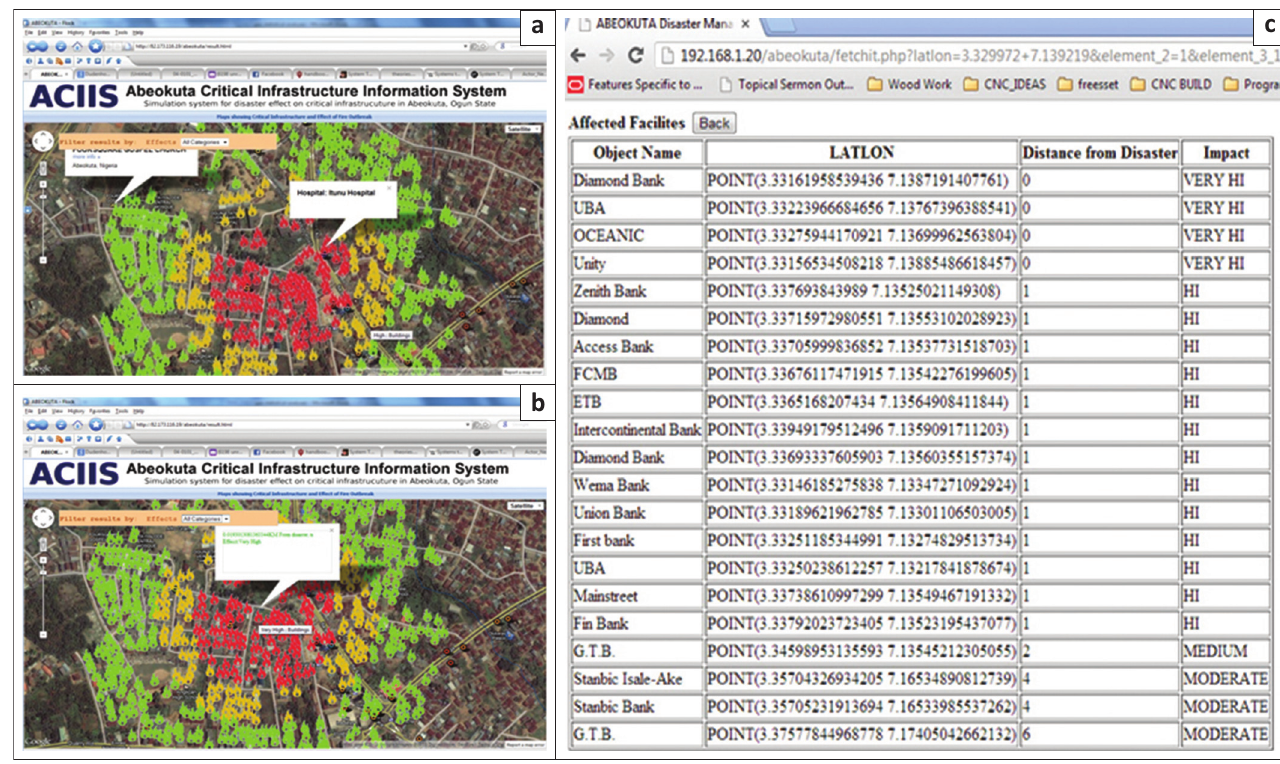
FIGURE 14: Formatted description of some affected facilities: (a) affected facilities, (b) positional description of an affected facility and (c) tabular description of some affected point-based